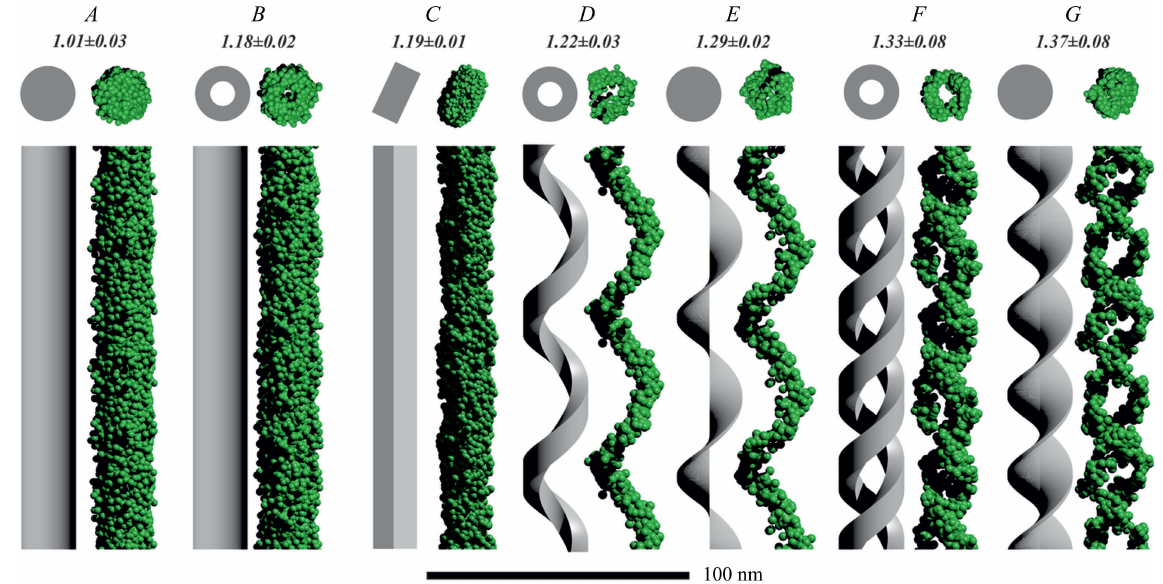
Figure 3 Theoretical and reconstructed three-dimensional models of the seemingly endless geometries used here. The numbers below the labels denote the mean normalized spatial discrepancy h NSD i , obtained from eight independent reconstructions (random artificial cylinder: h NSD i = 1.03 (cid:7) 0.01, random artificial single-strand helix: h NSD i = 1.06 (cid:7) 0.01). The PDDFs and dPDDFs used to determine the stacking distance between the building blocks can be found in Figs. S12 and S13. See Fig. 2 for the corresponding scattering intensities and Fig. S15 for point representations, as denoted by the letters A – G